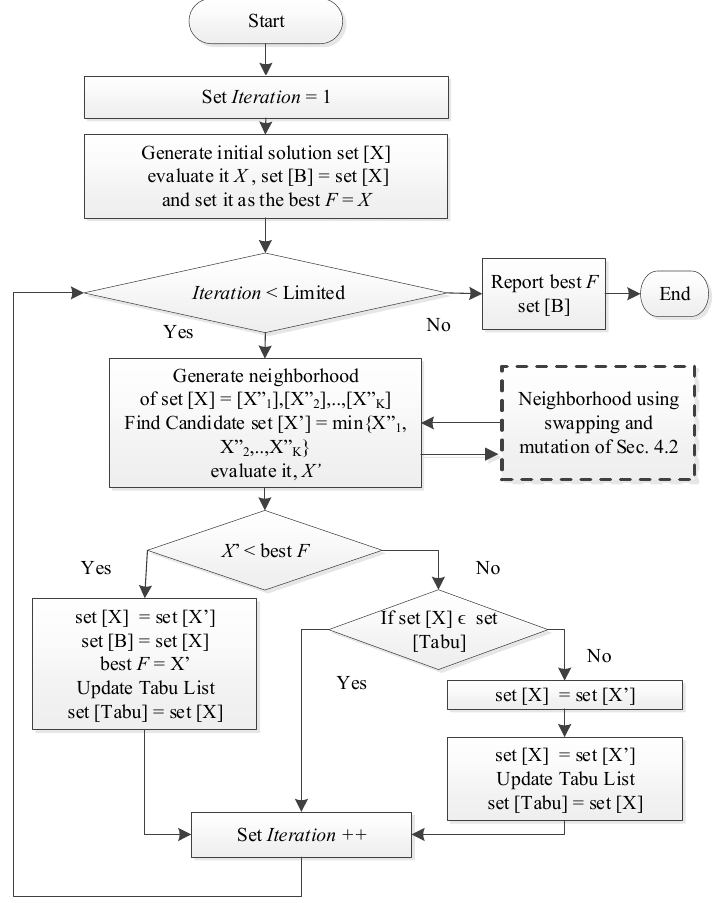
Fig. 4. Process flow of the TABU